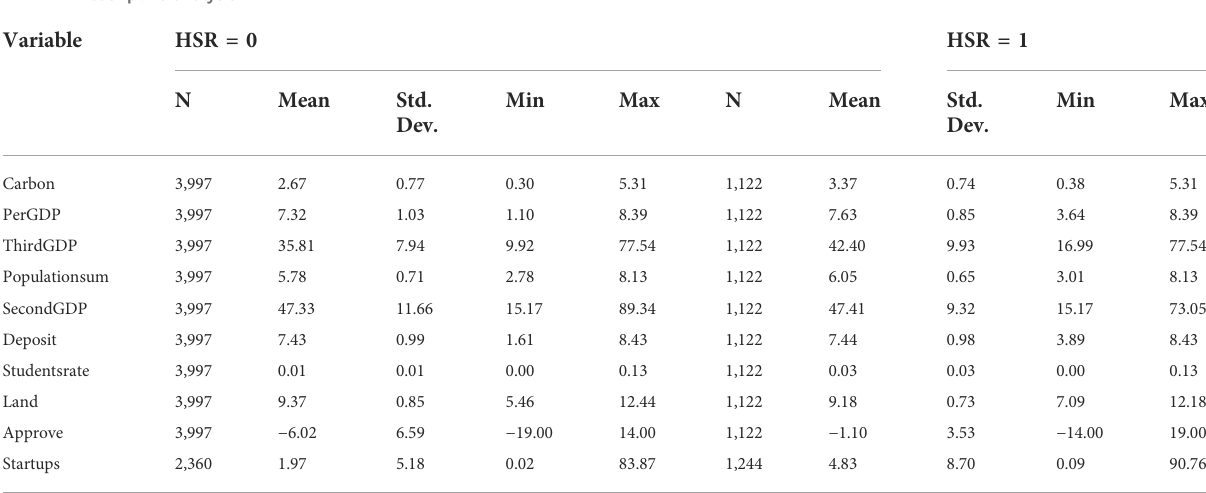
TABLE 2 Descriptive